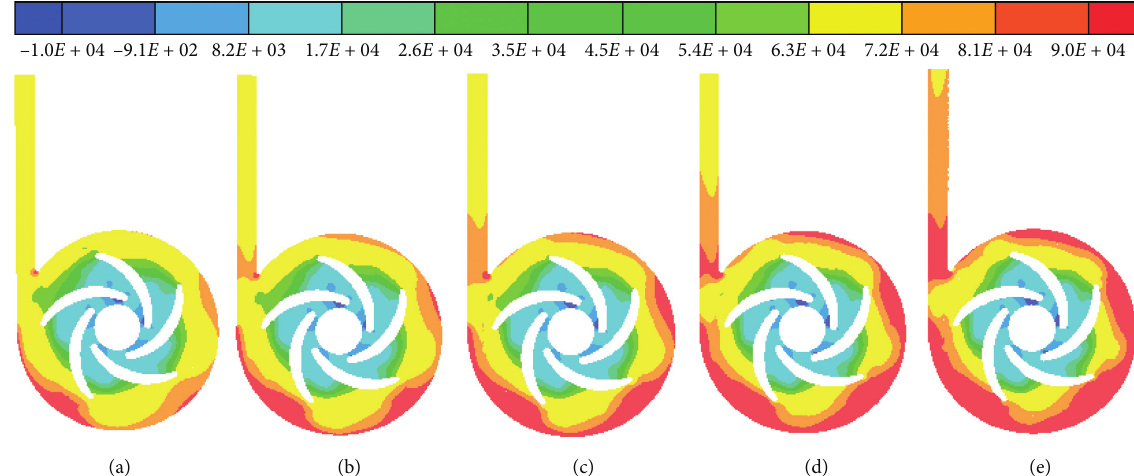
Figure 8: Cloud diagram of centrifugal pump pressure at different concentrations ( d � 0.1mm): (a) C C � 25%, and (e) C v